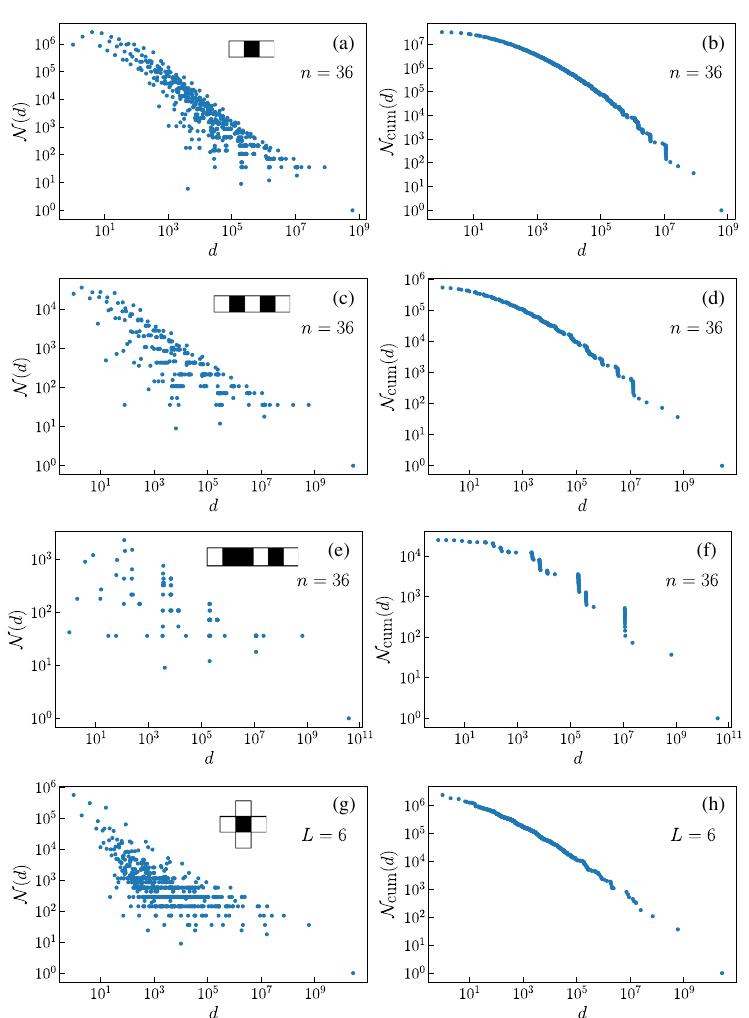
FIG. 2. Degeneracy distribution and cumulative degeneracy distributions for alternative filters to the one used in our main results. (a),(b) Filter pattern 01010 for binary input strings of length n ¼ 36 . (c),(d) Filter pattern 01010 for binary input strings of length n ¼ 36 . (e),(f) Filter pattern 011010 for binary input strings of length n ¼ 36 . (g),(h) Filter pattern (as illustrated herein) for 2D binary input grid of side length L ¼ 6 ( n ¼ 36 entries